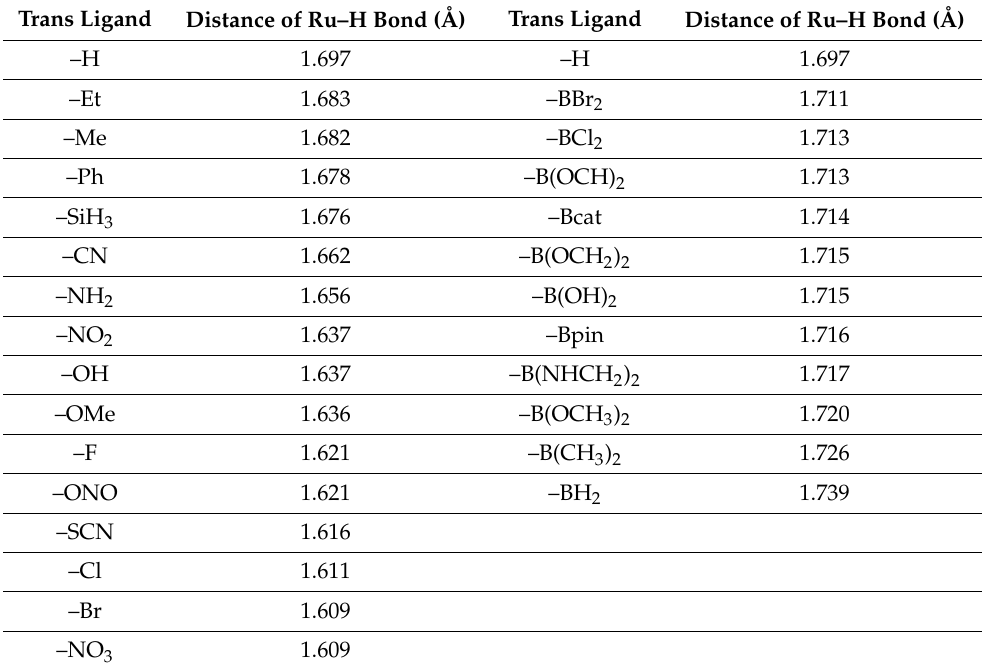
Table 1. Bond distance of the Ru–H bond on the Ru PNP-type complex with different trans ligands. Trans Ligand Distance of Ru–H Bond (Å) Trans Ligand Distance of Ru–H Bond (Å)